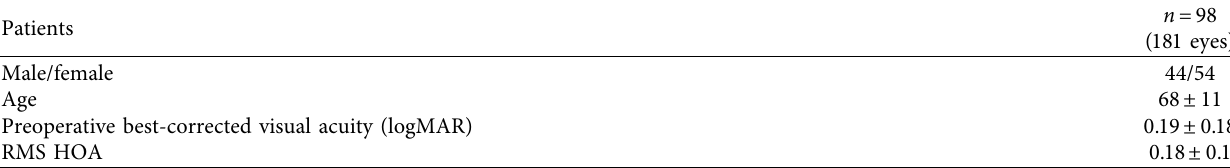
Table 1: Demographics of